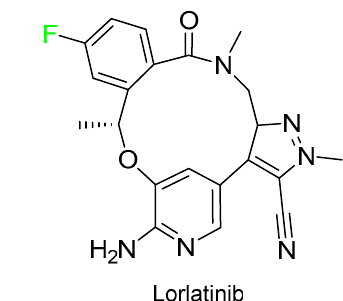
Figure 15. Structure of drugs for BRAF-mutated melanoma.